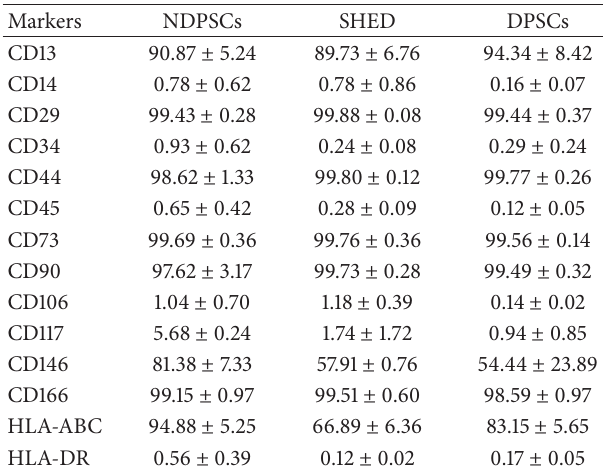
Table 1: Immunophenotypic characteristics of NDPSCs, SHED, and hDDP-MSCs. The figures in the table are percentages of CD positive